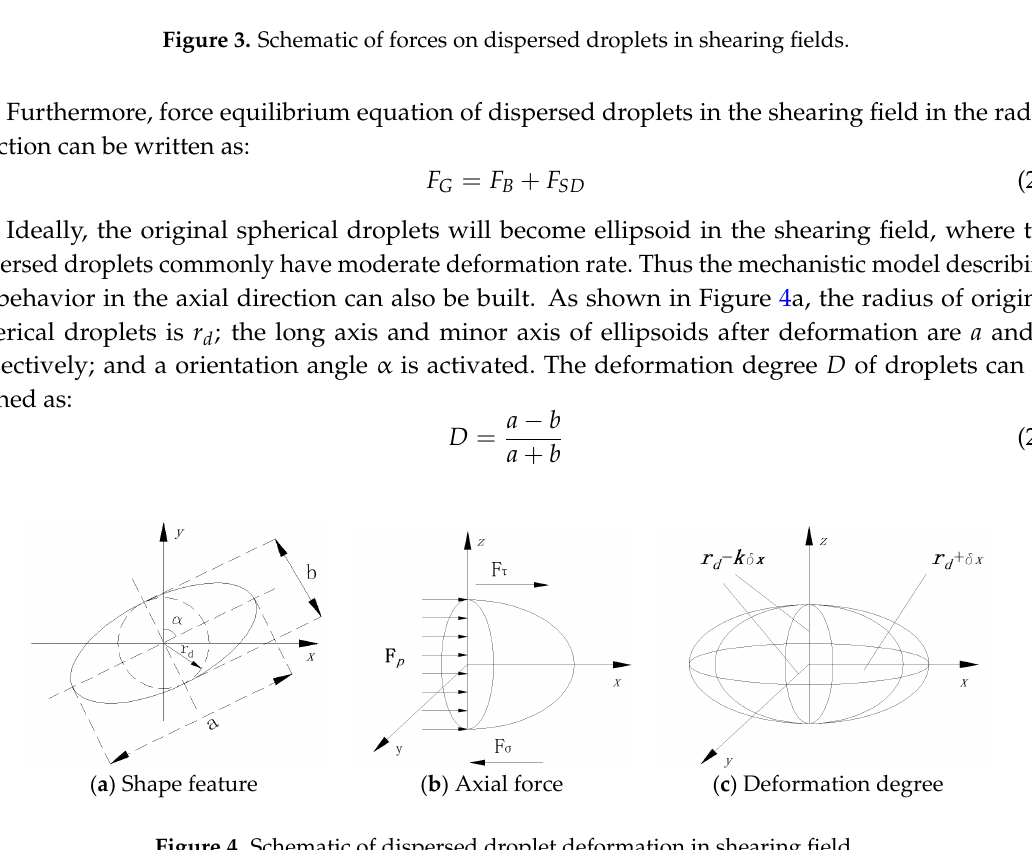
Figure 4. Schematic of dispersed droplet deformation in shearing field.